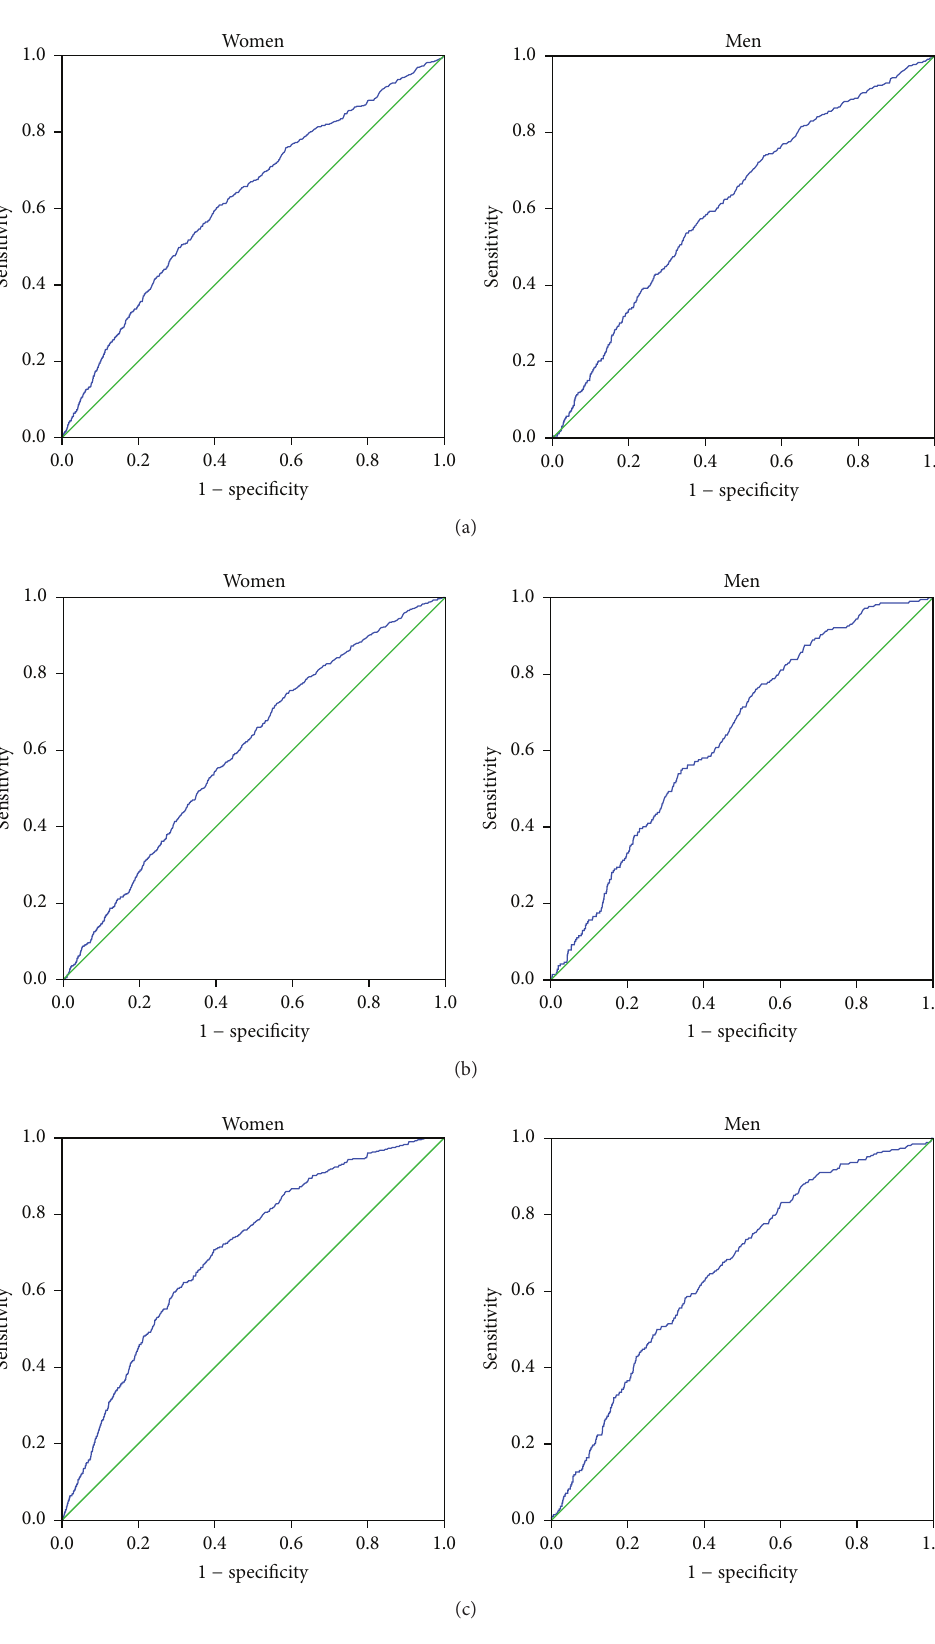
Figure 1: ROC curves in women and men new-onset DM groups diagnosed with (a) FPG, (b) 2-hPG, and (c) HbA1c criteria (ROC: receiver operating characteristic curve; FPG: fasting plasma glucose; 2-hPG: 2-hour plasma glucose during OGTT; HbA1c: hemoglobin